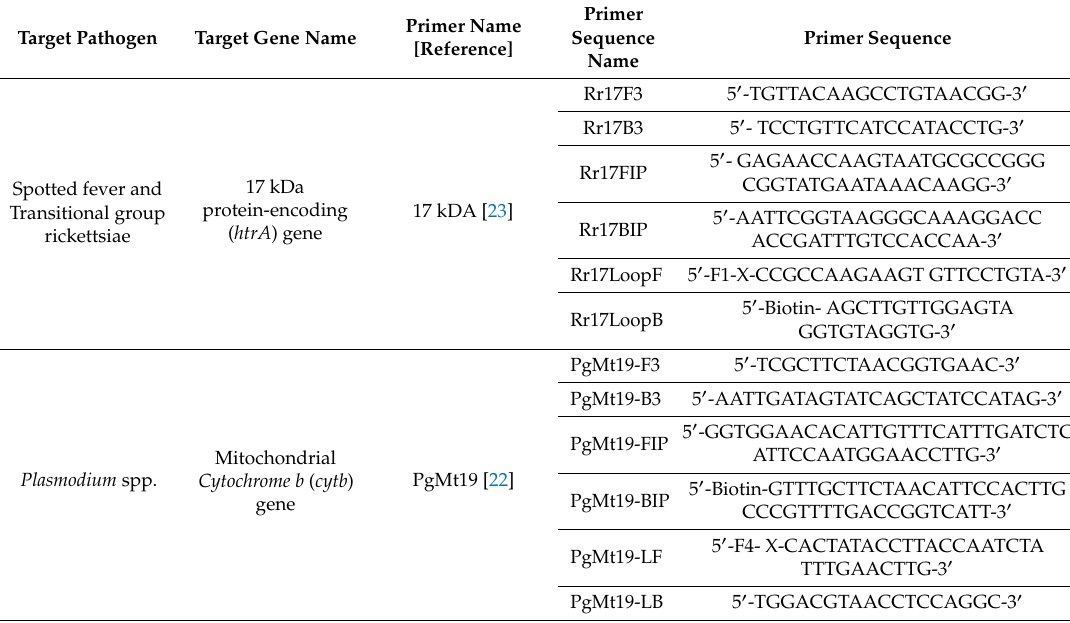
Table 1. Loop-mediated isothermal amplification primer sequences that were used for multiplex LAMP. Tagged and biotin-labeled primers are shown with F1 and F4, representing a unique tag sequence. “X” indicates the position of spacer C3 between the unique tag sequence and the LAMP primer